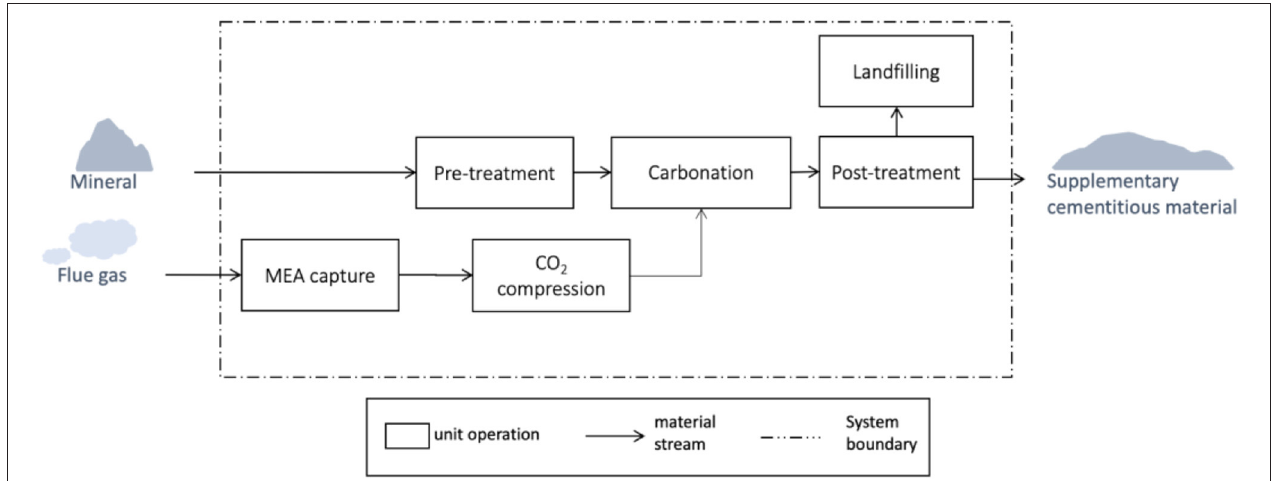
FIGURE 1 | Direct aqueous carbonation unit operations and system adapted from Strunge (2022).